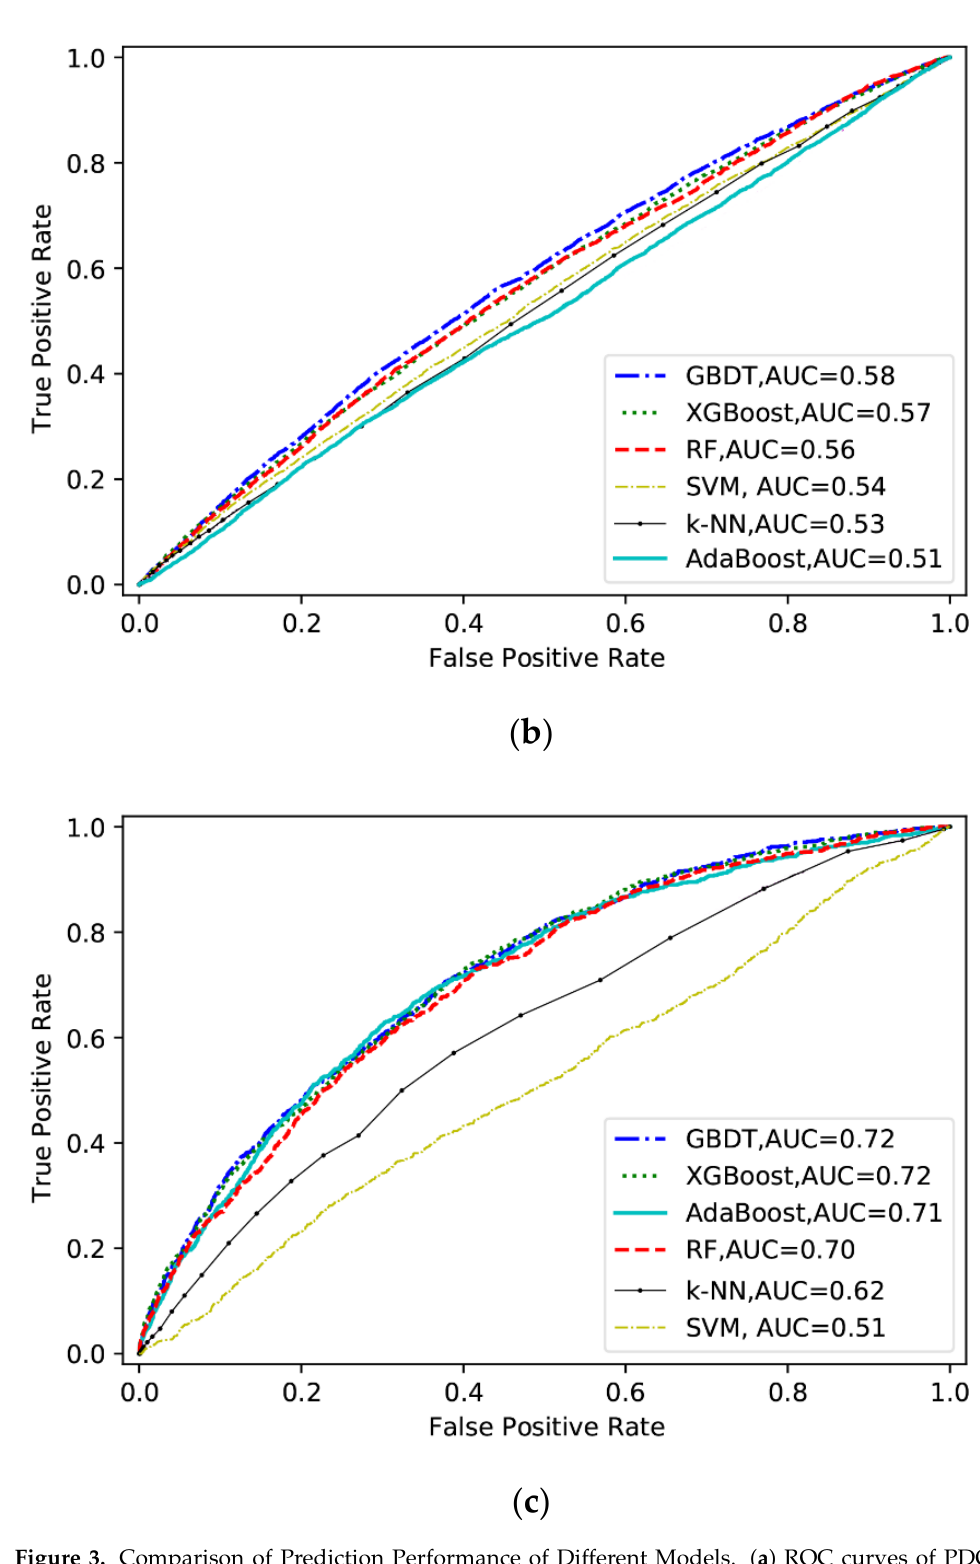
Figure 3. Comparison of Prediction Performance of Different Models. ( a ) ROC curves of PDO-level crash prediction. ( b ) ROC curves of SLIG-level crash prediction. ( c ) ROC curves of KSEV-level crash prediction.